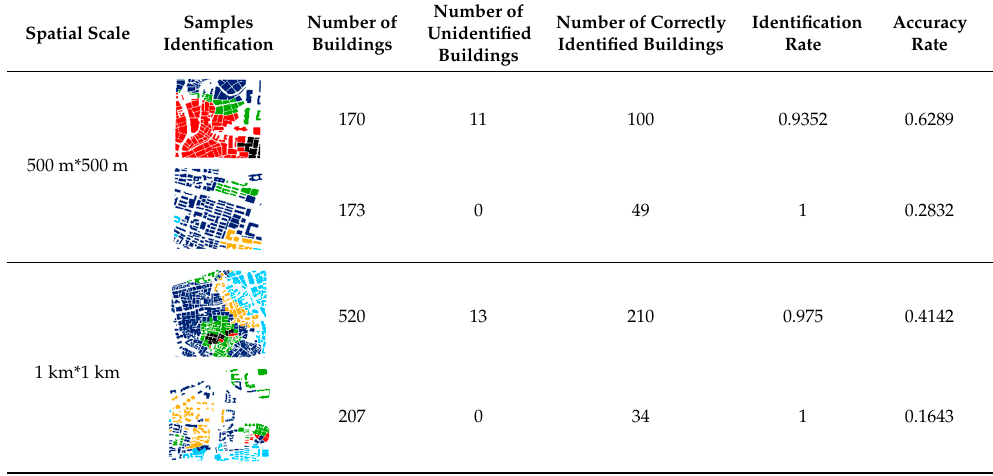
Table 4. The accuracy rate of identifying buildings with di ff erent spatial scales using the traditional method.